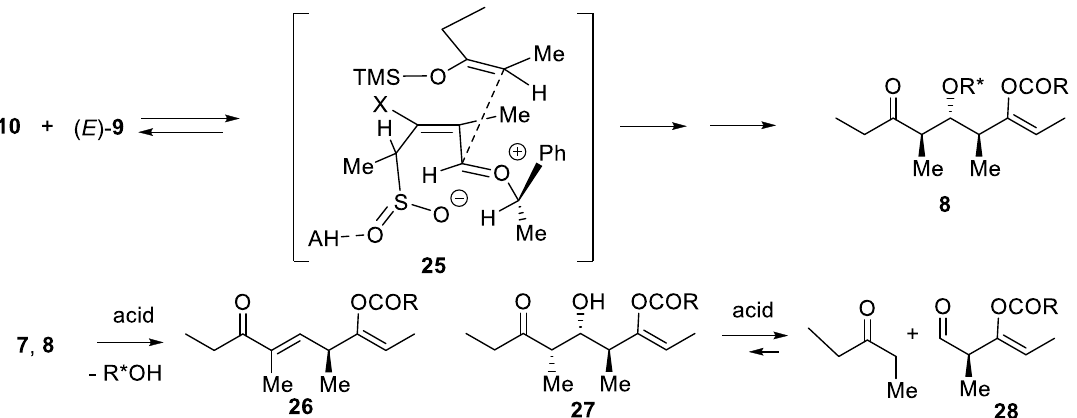
Scheme 4. Mechanism for the preparation of the anti,anti -stereotriad 8 and formation of co-products under acid-induced desulfinylation.